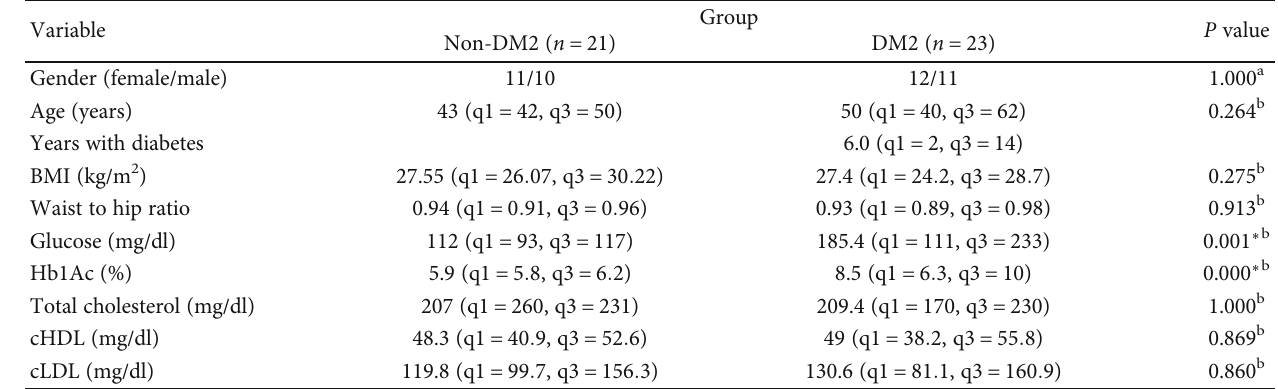
Table 1: Clinical features of